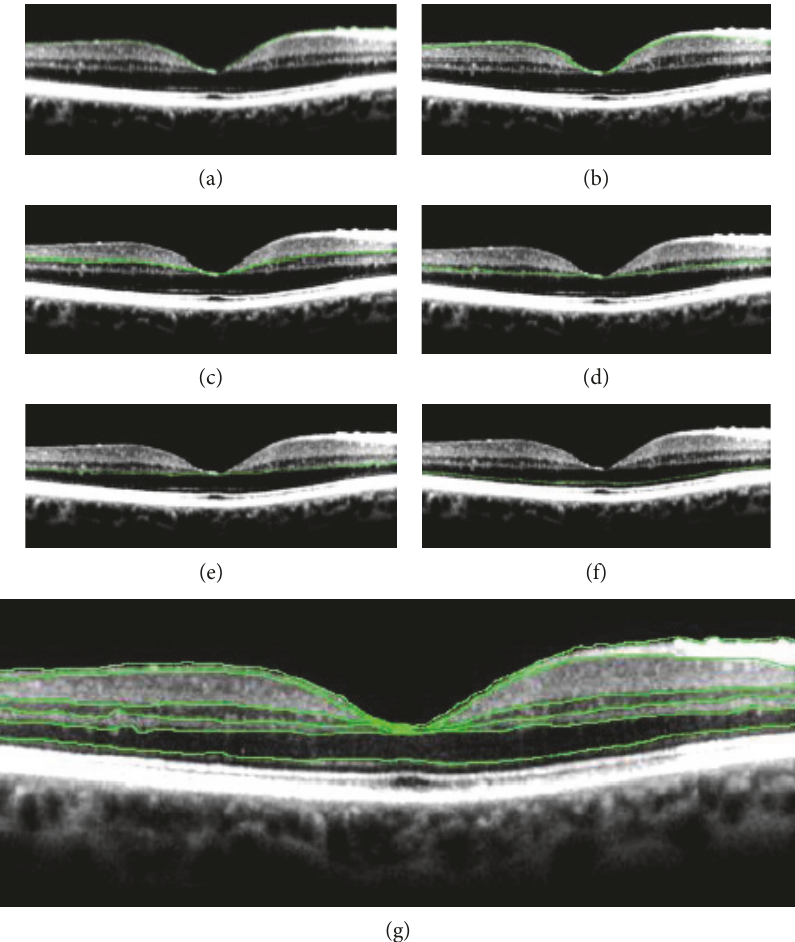
Figure 2: Example of manually annotated borders of the individual retinal layers on an optical coherence tomography scan. (a) Border between vitreous and NFL, (b) border between NFL and GCL, (c) border between IPL and INL, (d) border between INL and OPL, (e) border between OPL and ONL, (f) border between ONL and ELM, and (g) all annotated borders. Annotations were performed on each scan with di ff erent averaging settings; thus, on 7 scans preoperatively and 7 scans postoperatively for each